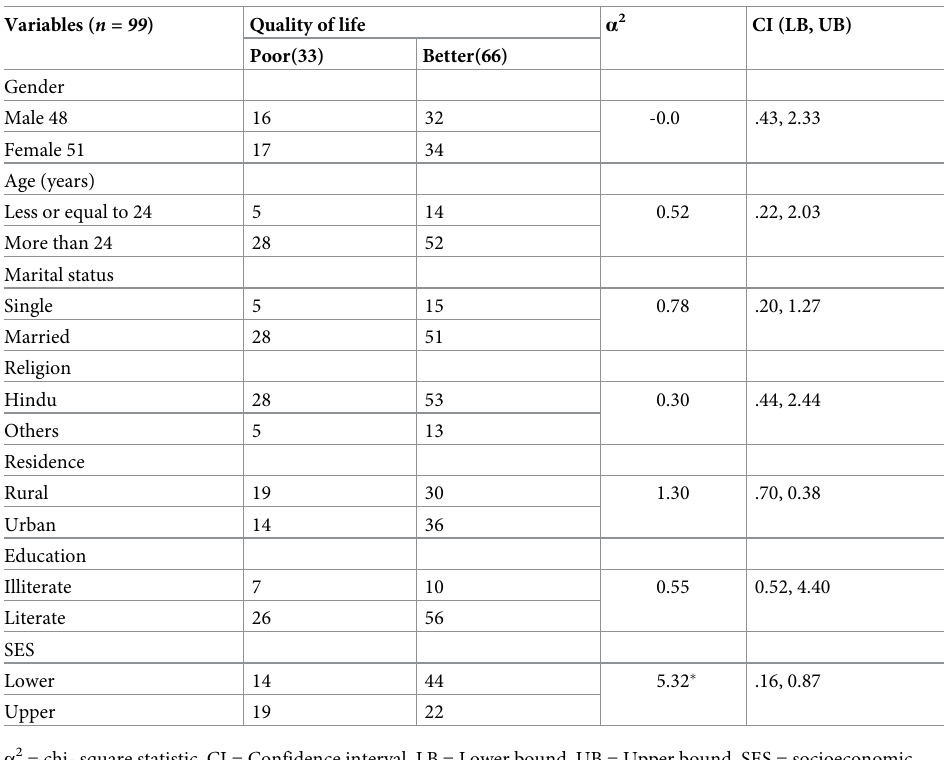
Table 1. Sociodemographic variables and quality of